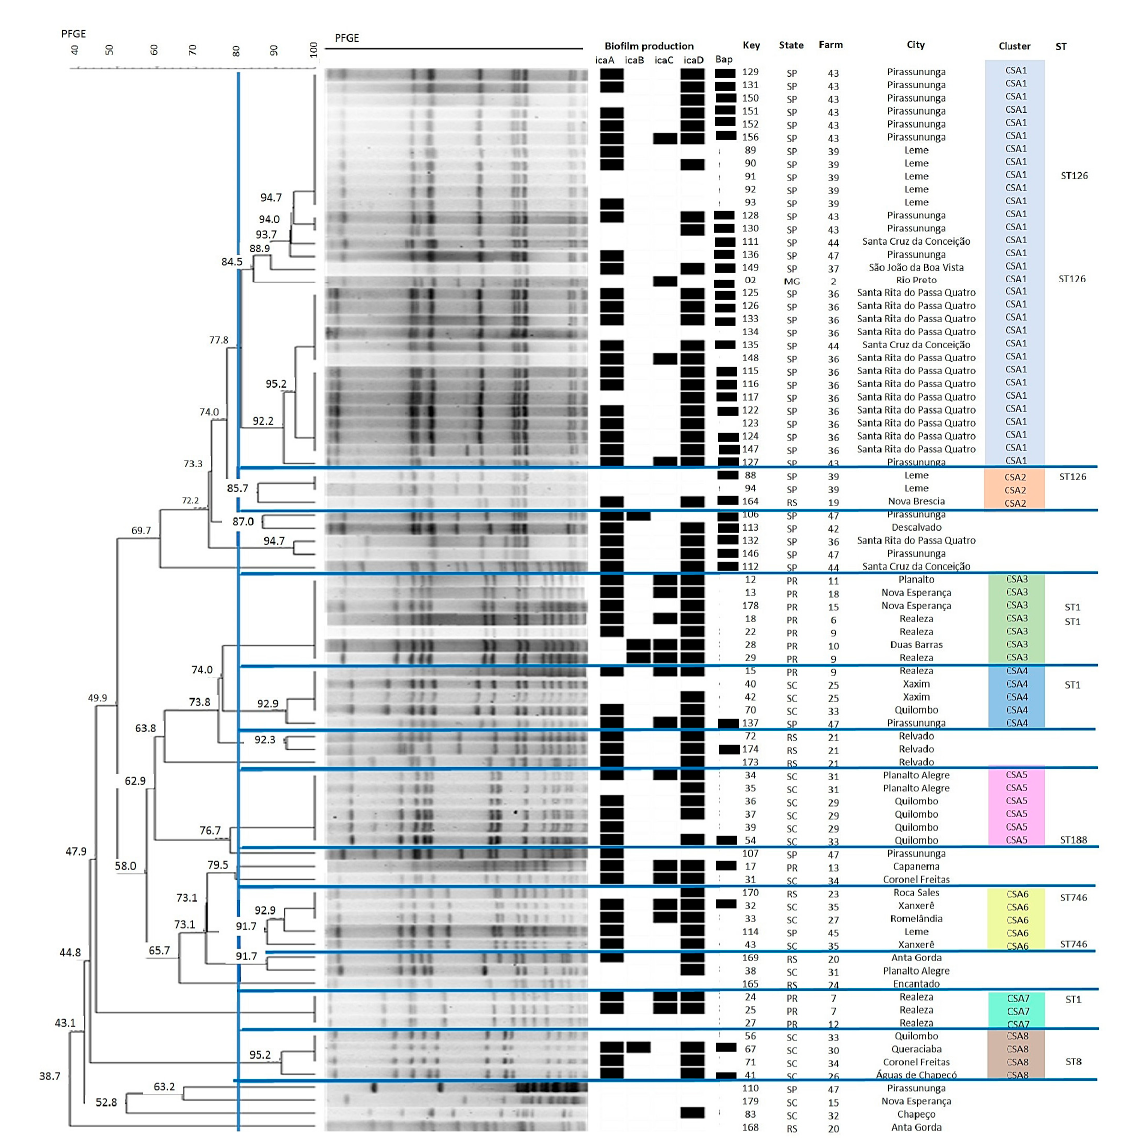
Figure 2. Dendrogram generated from the pulsed-field gel electrophoresis PFGE pattern of Staphylococcus aureus isolates (Dice similarity coe ffi cient; clustering method: Unweighted Pair Group Method with Arithmetic Mean-